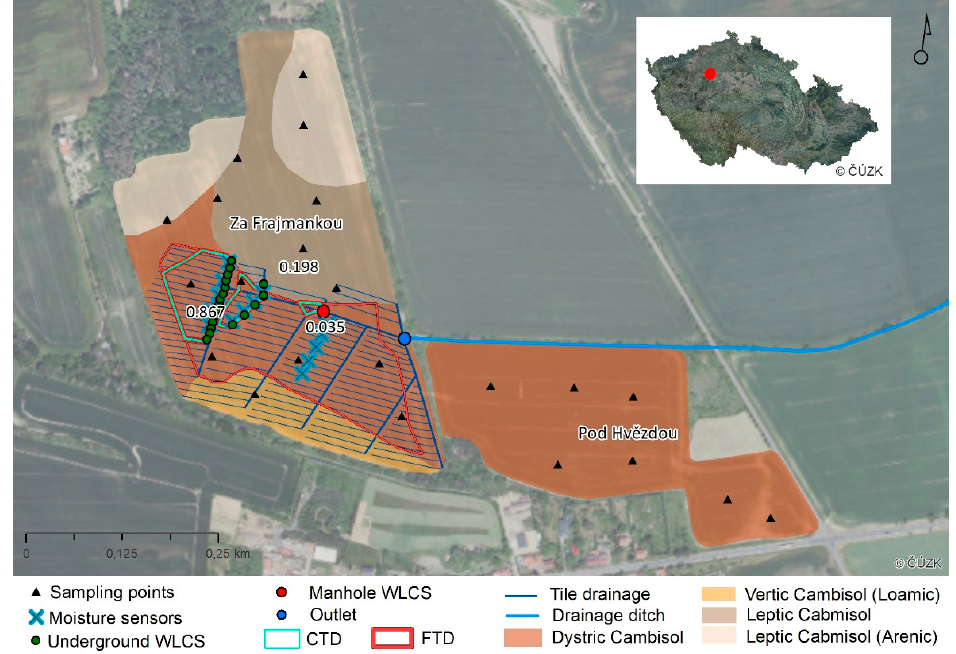
Figure 1. Experimental fields Za Frajmankou and Pod Hv ě zdou with soil types, sampling points, moisture sensors, underground and manhole water level control structures (WLCS), outlet, drainage ditch and map of the Czech Republic with marked study site. CTD – control tile drainage sites, FTD – free tile drainage sites .